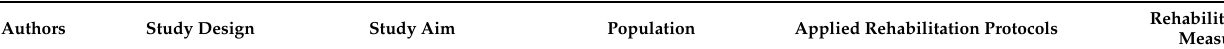
Table 1. Summary of all included